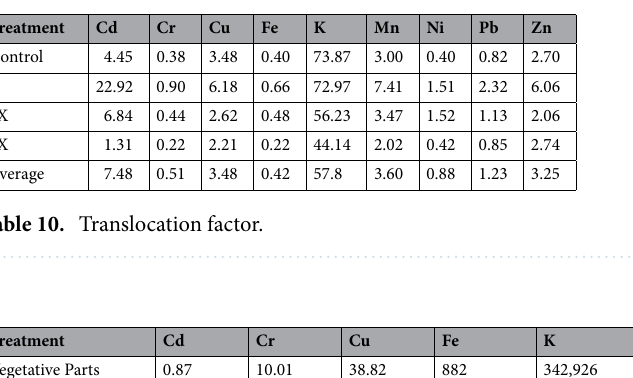
Treatment Cd Cr